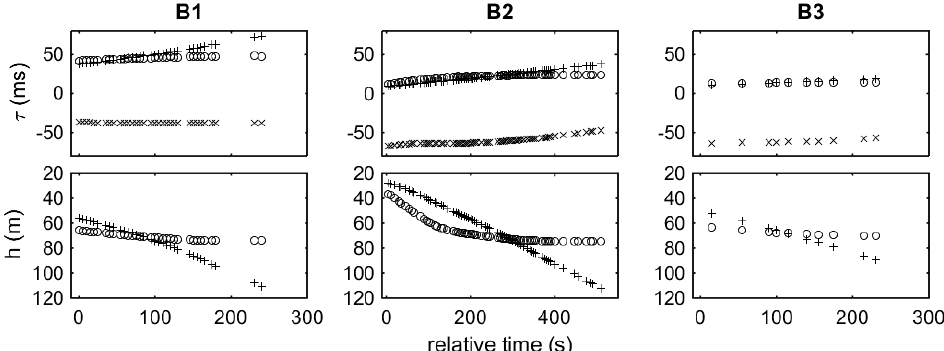
Figure 10. TDOAs and hydrophone depths during stations B1–B3 of the deep-water pinger localization experiment for front hydrophone ( ◦ ), rear hydrophone (+) and τ 21 ( ×